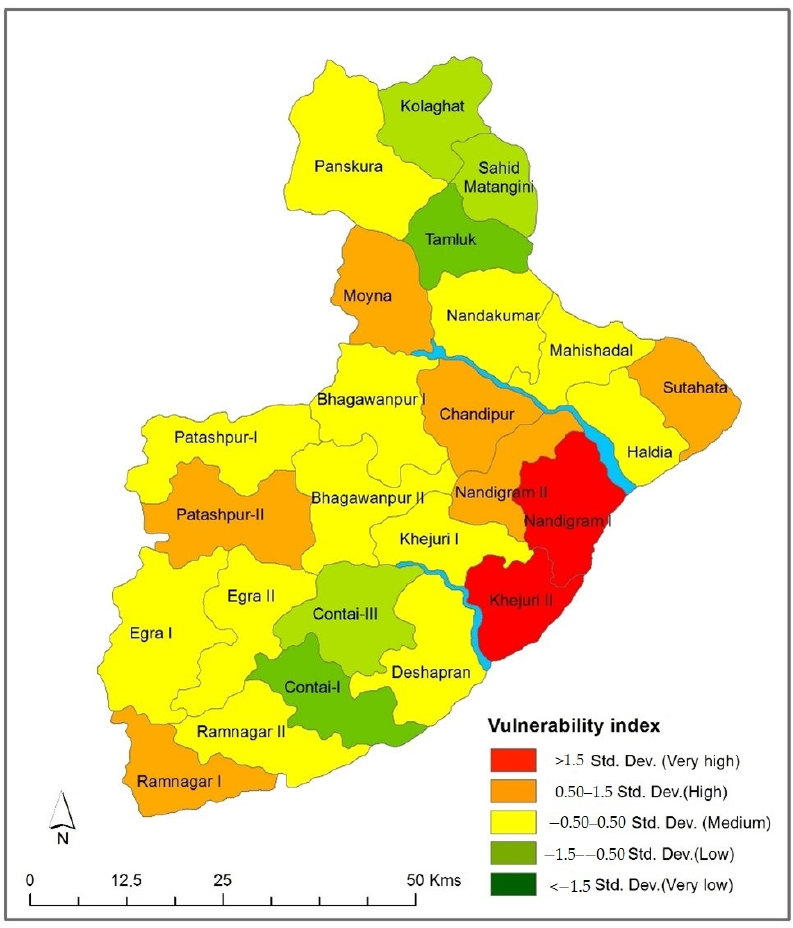
Figure 8. Vulnerability map of Purba Medinipur district.